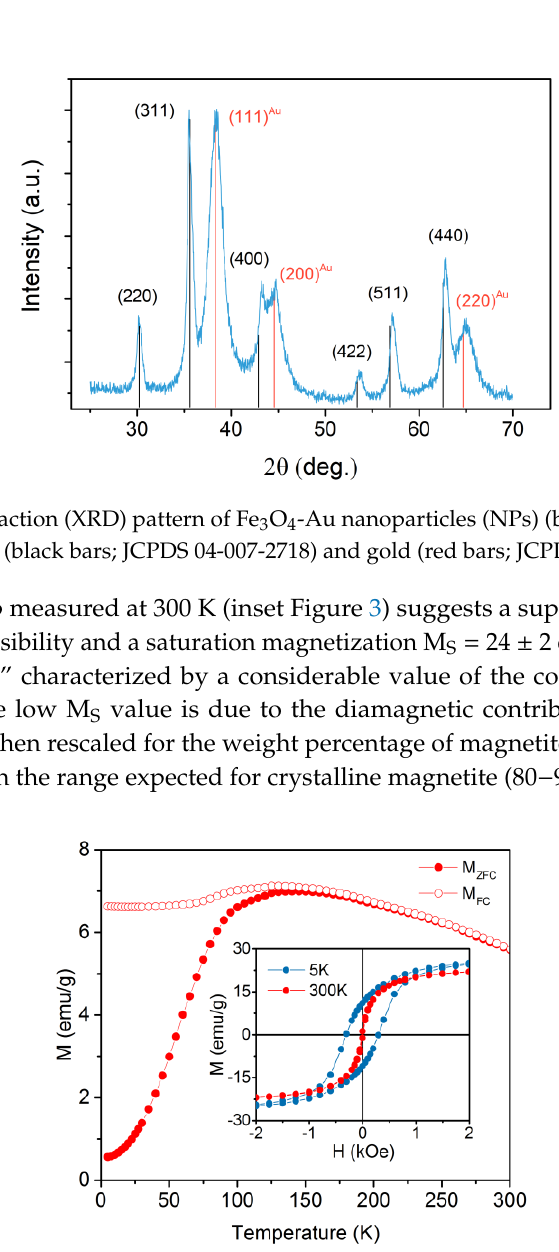
Figure 3. Zero-field cooled and field-cooled (ZFC / FC) magnetizations of Fe 3 O 4 -Au NPs. In the inset, the hysteresis loops at 5 and 300 K in the low magnetic field range are reported.